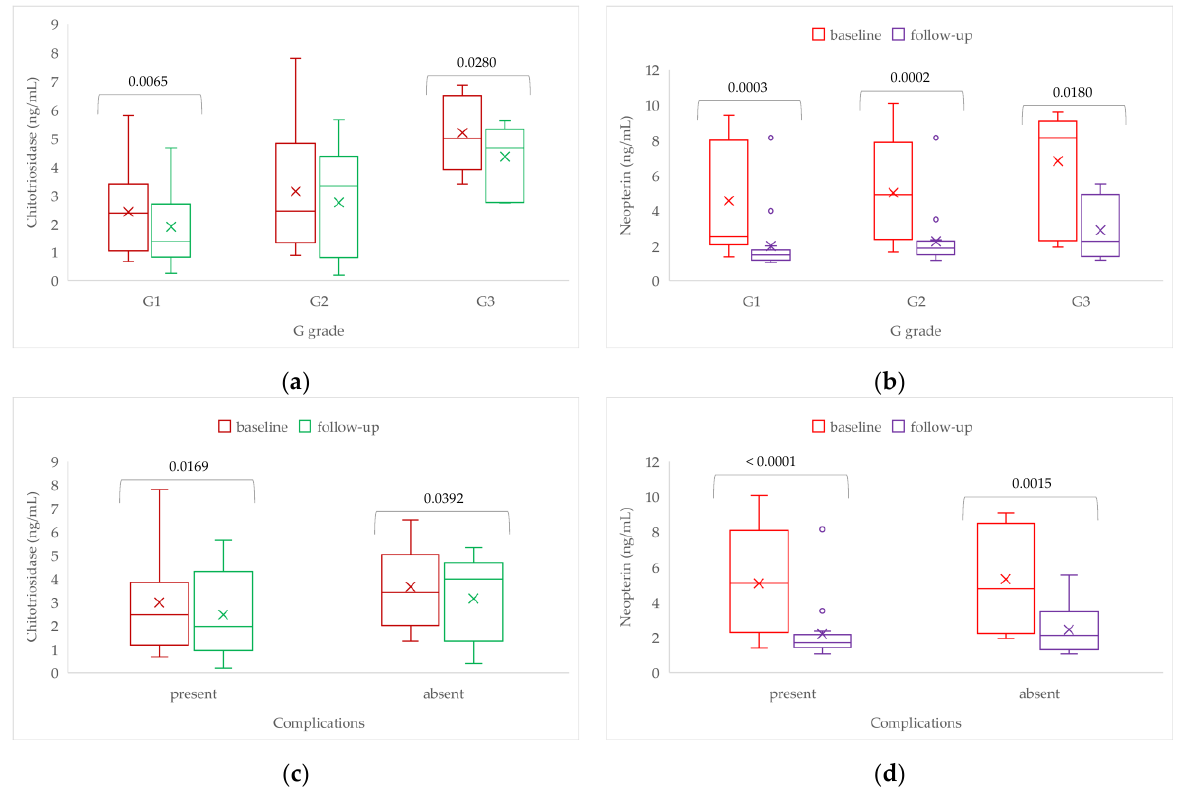
Figure 5. Baseline vs. follow-up chitotriosidase and neopterin differences according to ( a ) and ( b ) differentiation grade (G-grade); ( c ) and ( d ) presence or absence of complications. The × in the box indicates the mean value, the line in the box corresponds to the value of the median, the lower and upper bound of the box corresponds to the value of the first (lower) and third (upper) quartile, and the whisker corresponds to the values of minimum and maximum. The extreme values are shown as “o”. The differences between baseline and follow were tested with Wilcoxon matched pairs test.